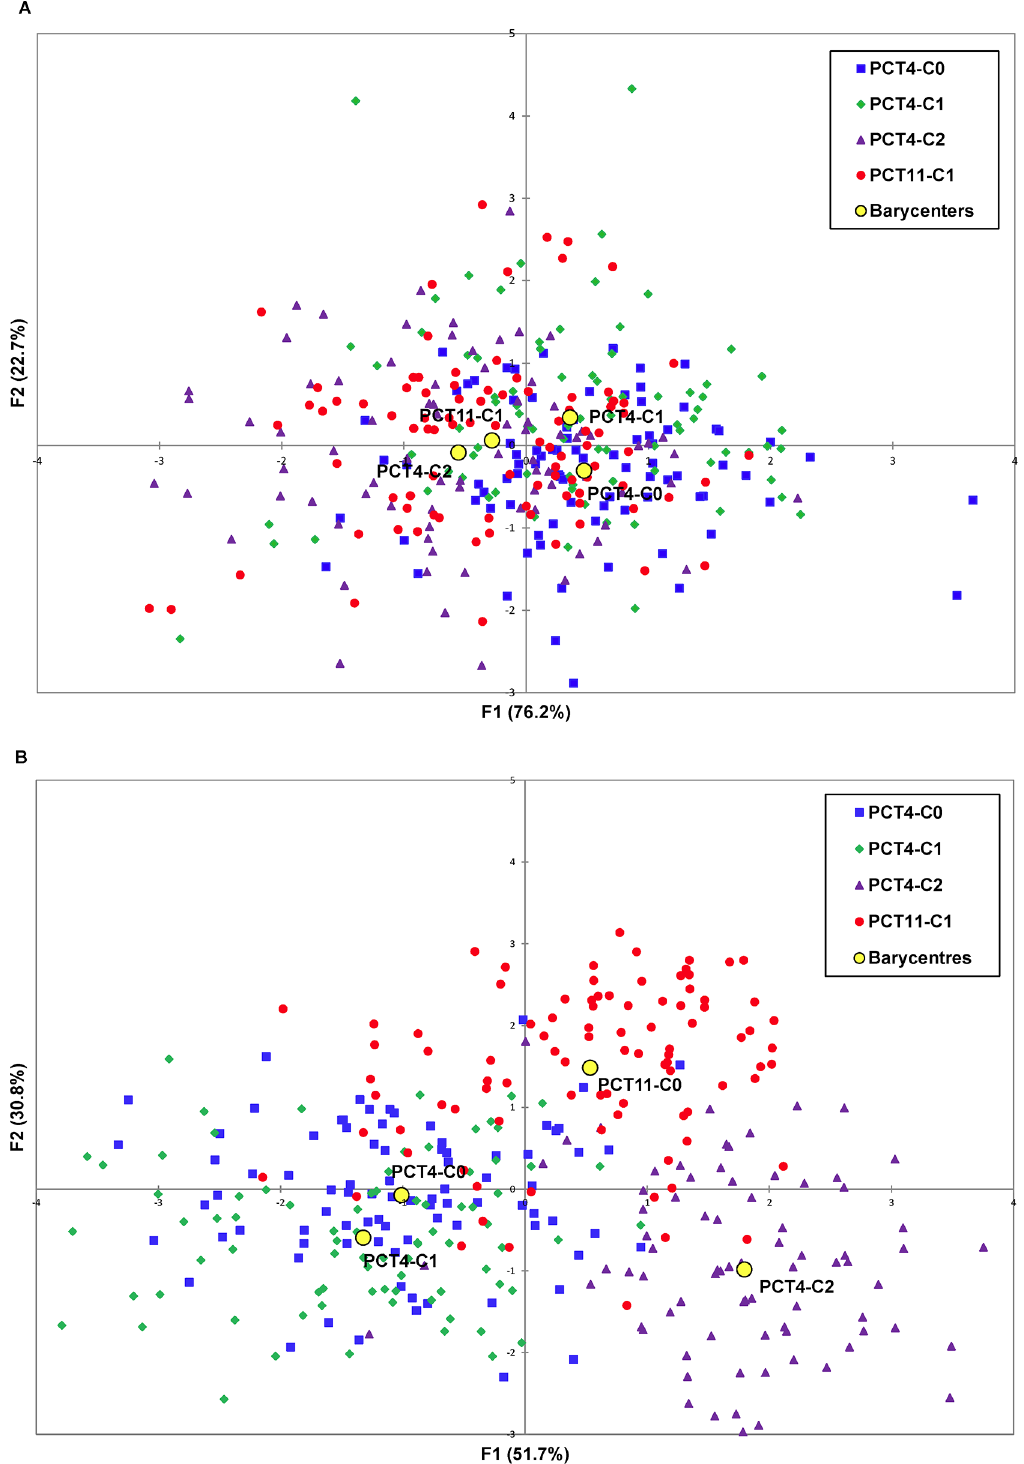
Fig 1. Projection of the 343 S 2:3 lines on the first plane of a factorial discriminant analysis using (A) phenotypic data and (B) genotypic data.